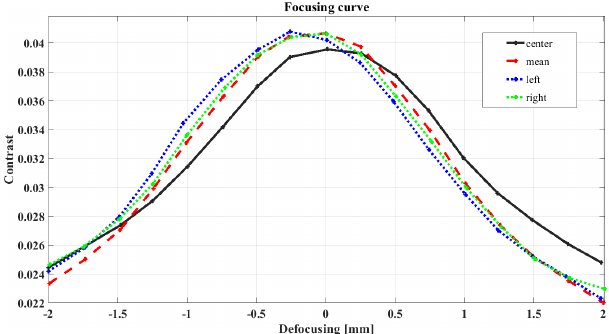
Figure 5. Typical focus calibration; contrast is calculated in three sectors of the image: centre, left, and right. The contrast through- out the image is also displayed (red). The slight difference in focus (0.2mm) between the centre of the image and the side wings is a normal lens effect.